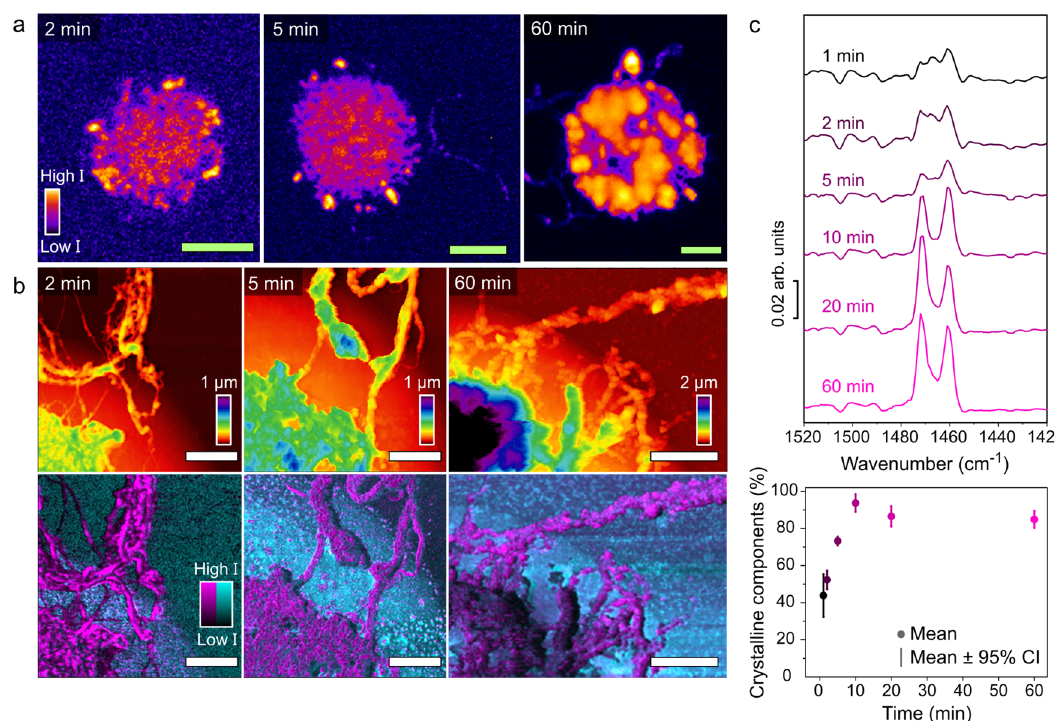
Fig. 3 | Raman microscopy and photo-induced force microscopy (PiFM) to study the crystallization of the formed polyethylene after 2, 5 and 60min of ethylene polymerization. a Raman microscopy maps of the asymmetric and symmetric -CH 2 - stretching vibrations in the 2700 – 3100cm − 1 region. b The topo- logical (top) and PiFM (bottom) images of zoom-ins on the spherical caps. The PiF images show the distribution of the -CH 2 - symmetric bending mode peaks in magenta and LaOCl surface adsorbed carbonate species acting as markers for LaOClincyan.Thegreen(Ramanmicroscopy)andwhite(PiFMtopology)scalebars represent a width of respectively, 10 µ m and 2 µ m. c The photo-induced force (PiF) spectra that give the -CH 2 - symmetric bending mode peaks of crystalline